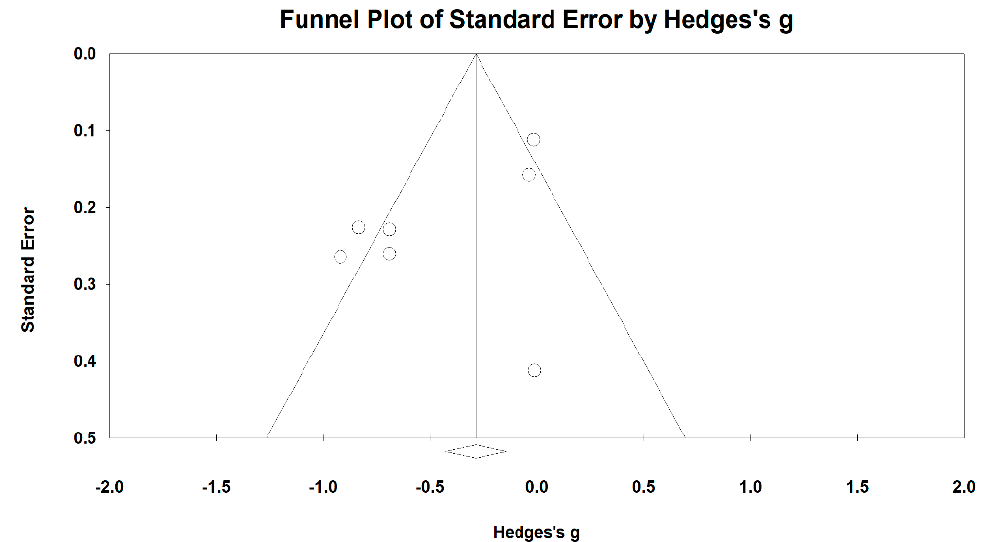
Figure 12. Funnel plot of publication bias for quality of life.